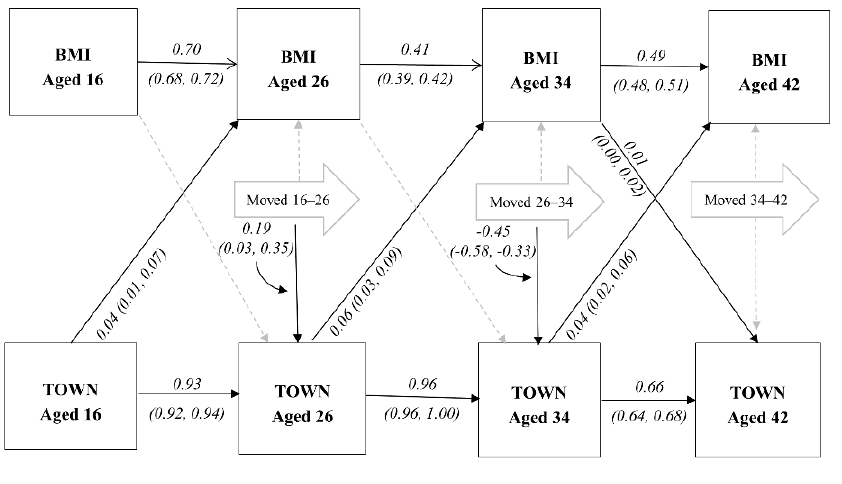
Figure 2. Structural equation model with both area deprivation, health selection and mobility paths across the life course: 1970 British Cohort ( n = 18,639). Dotted line indicates non-significant paths ( p > 0.05). BMI = body mass index; TOWN = Townsend area deprivation score.